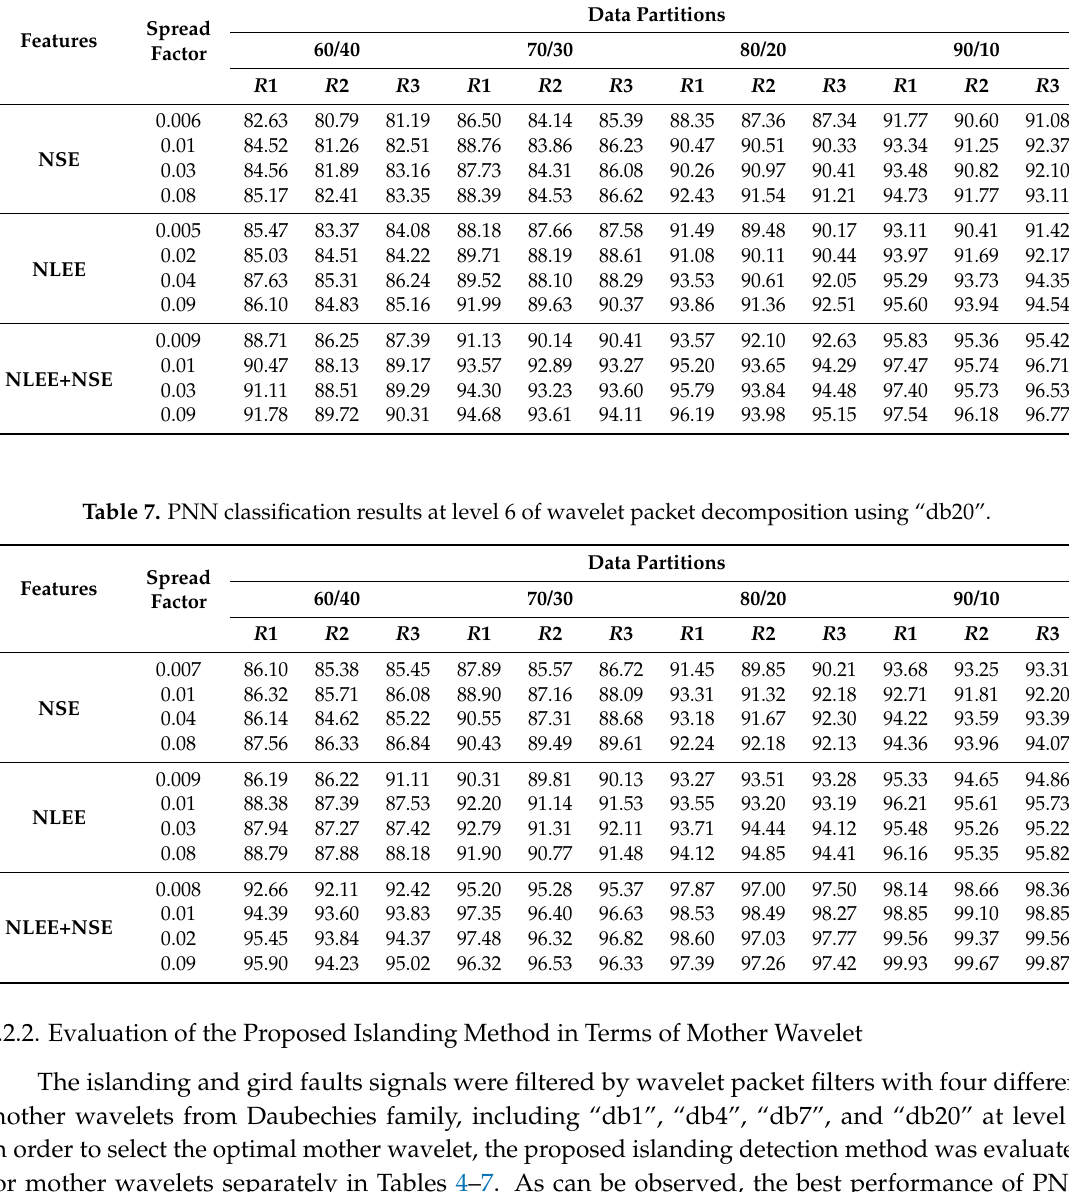
Table 6. PNN classification results at level 6 of wavelet packet decomposition using “db7”. Features